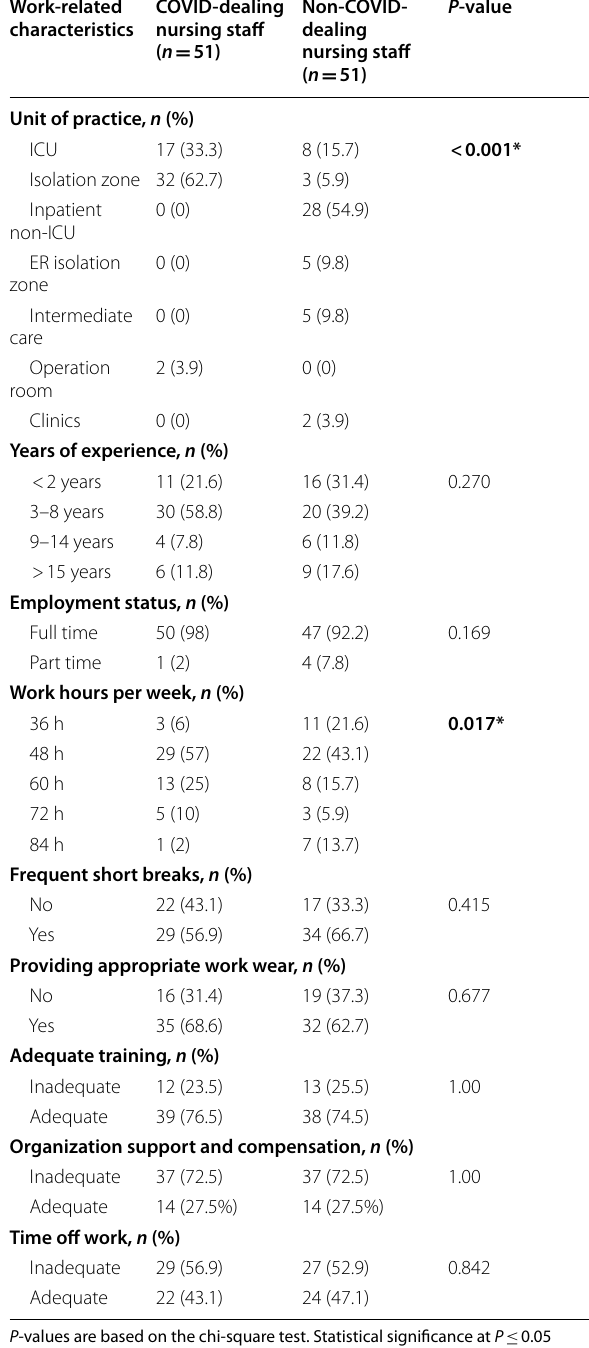
Table 2 Work-related characteristics of the studied population Table 3 PTSD symptoms, severity, and diagnosis among nursing